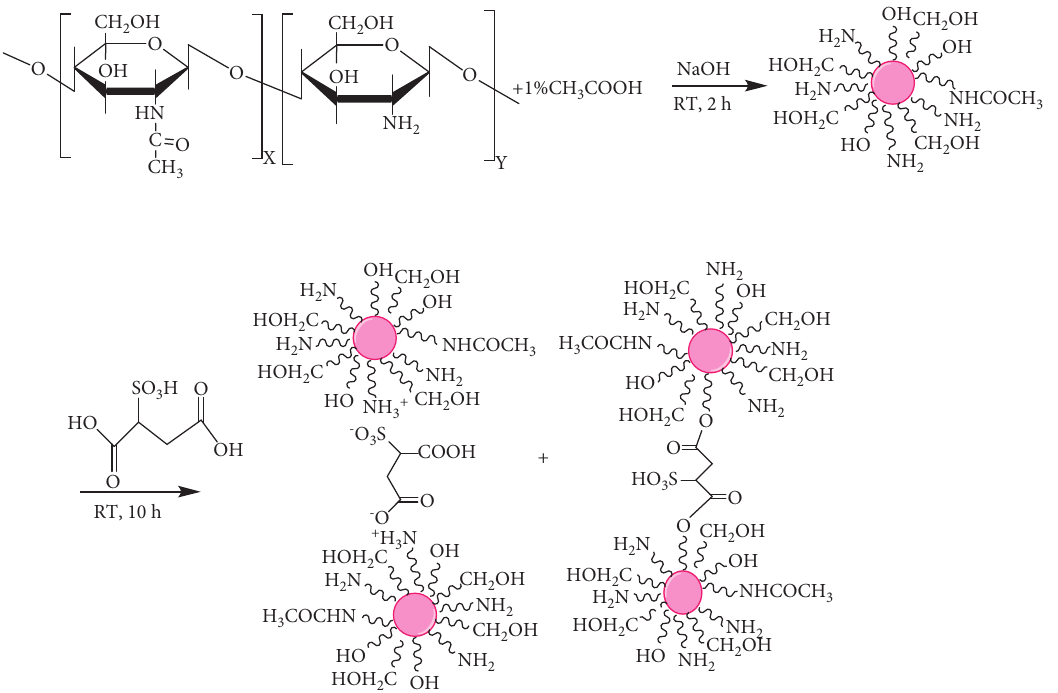
Figure 5: Synthesis of CSA catalyst. Reproduced with permission from [43] copyright 2019, Elsevier.